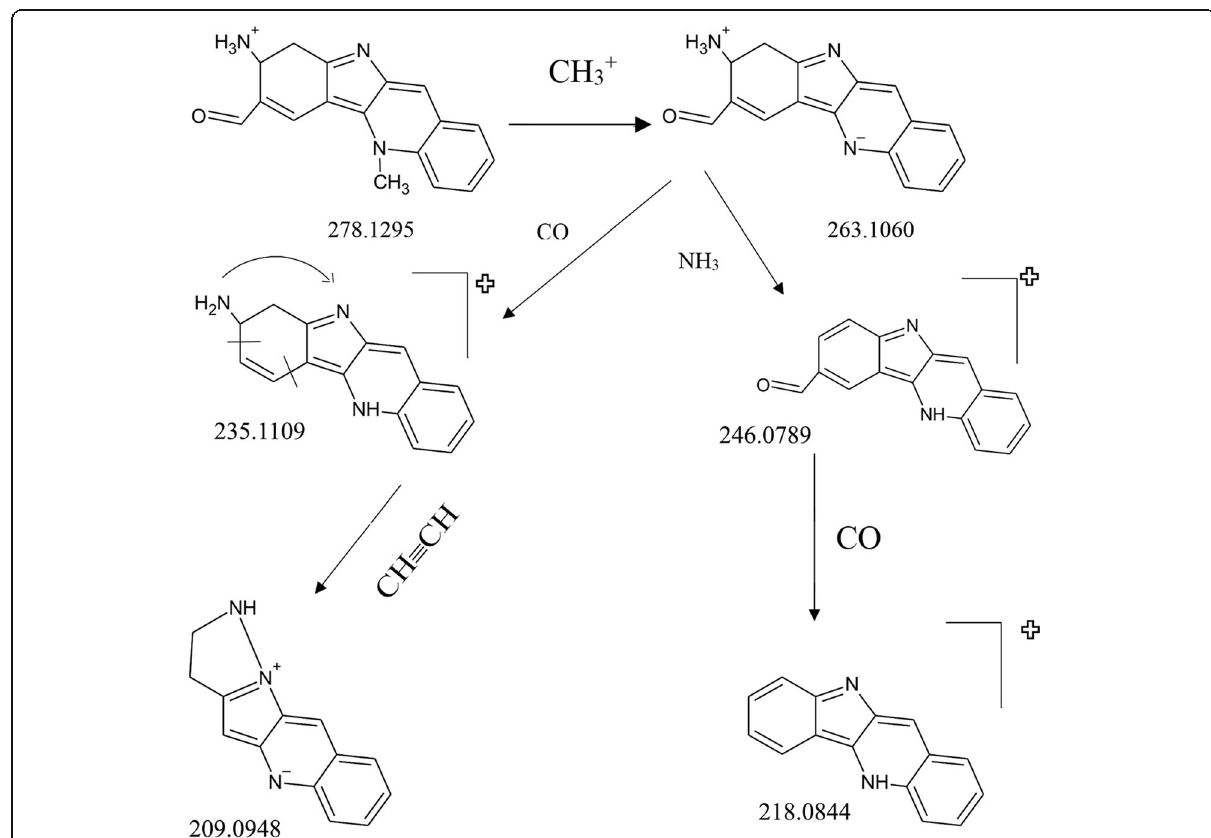
Fig. 7 Proposed chemical structure of compound 3 and its fragment ions with the respective exact